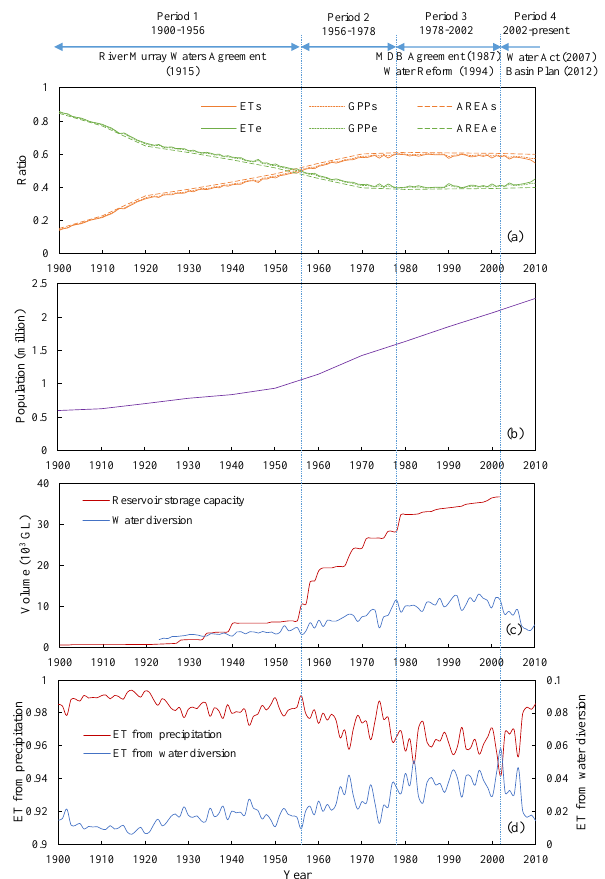
Figure 4. Time series of (a) the ratios of ET, GPP and land area for the societal and ecological systems; (b) population; (c) water diversion and reservoir storage capacity; and (d) the ratios of ET from precipitation and water diversion in the MDB from 1900 to